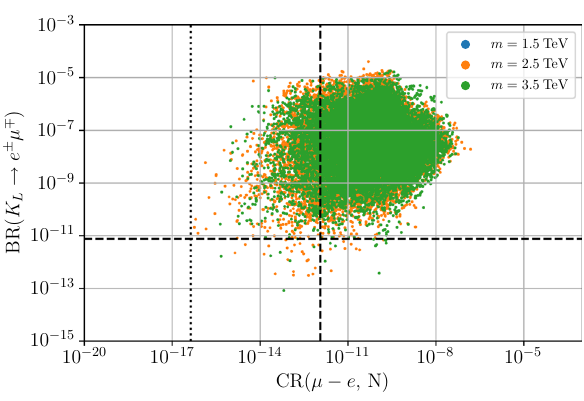
Fig. 2 Result of a random scan around the best-fit point (without the inclusion of cLFV bounds on CR (μ − e , Au ) and BR ( K L → e ± μ ∓ ) as inputs to the fit). Following a sampling of the global likelihood(s) via MCMC, the sample points shown in the plot are drawn from the posterior distributions of the leptoquark couplings (cf. Appendix A). The colour scheme reflects the mass benchmark points: blue, orange and green respectively associated with m V = 1 . 5 , 2.5 and 3.5 TeV. The dashed lines indicate the current bounds at 90% CL, while the dotted line denotes the envisaged future sensitivity of the COMET and Mu2e experiment (for Al nuclei)